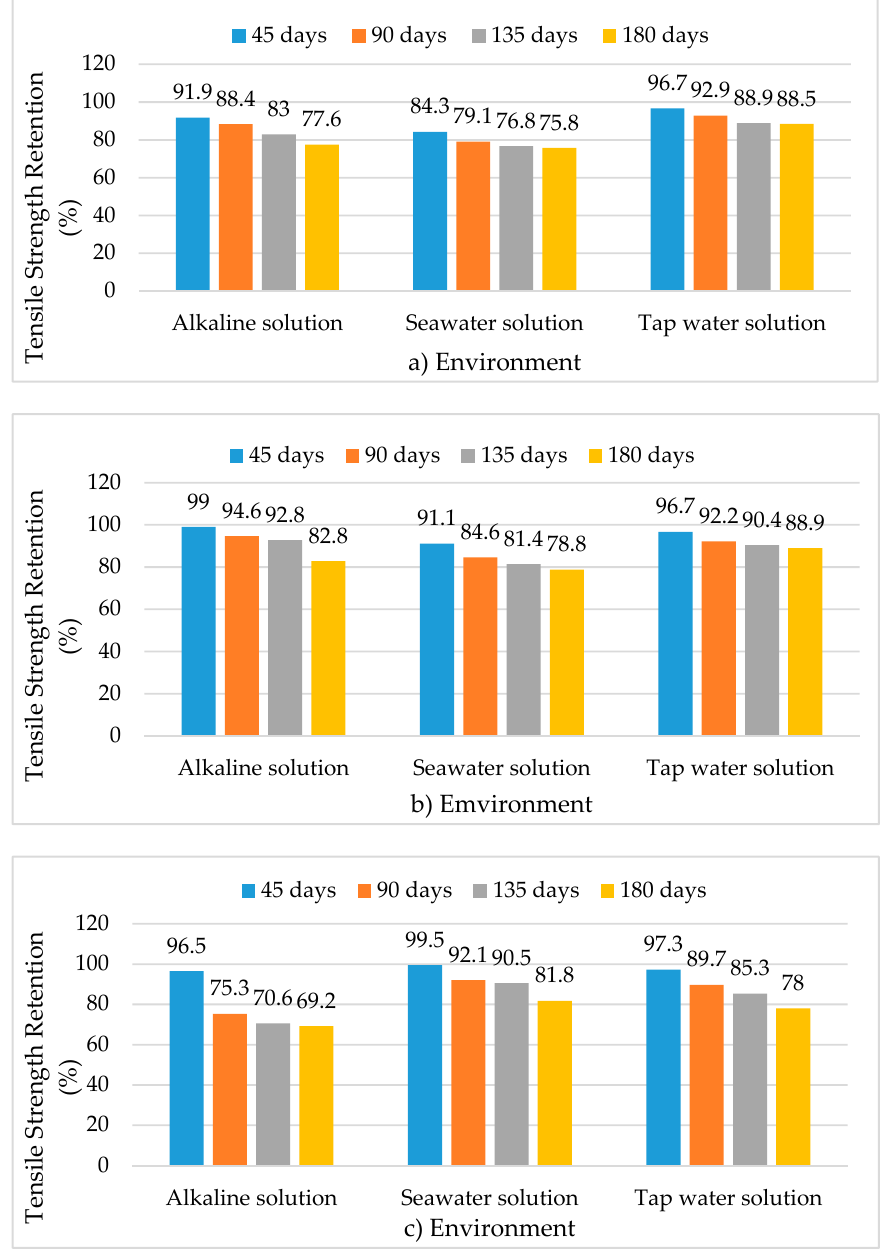
Figure 9. Tensile strength retention in 8 mm diameter FRP bars made of vinyl ester matrix subjected to three environments with bars made of ( a ) BFRP fibers, ( b ) CFRP fibers, ( c ) GFRP fibers. Reprinted with permission from ref. [48]. Copyright 2021 American Society of Civil Engineers